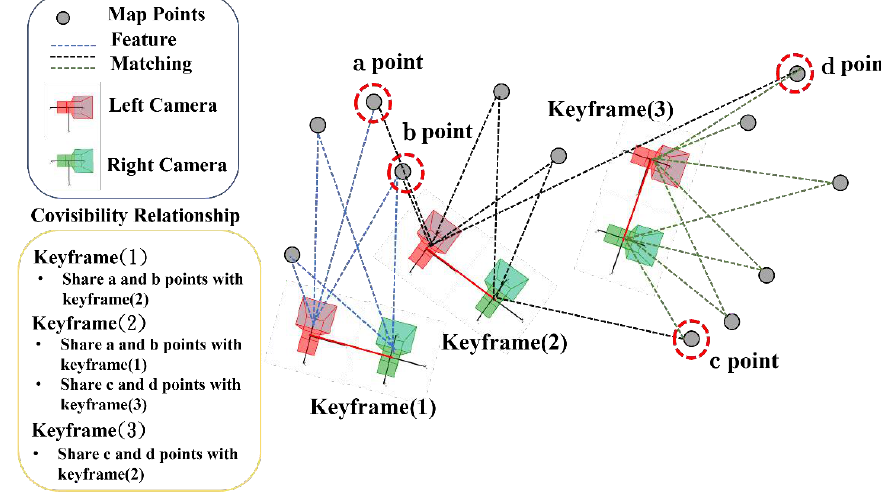
Figure 4. Illustration of covisibility relationship.